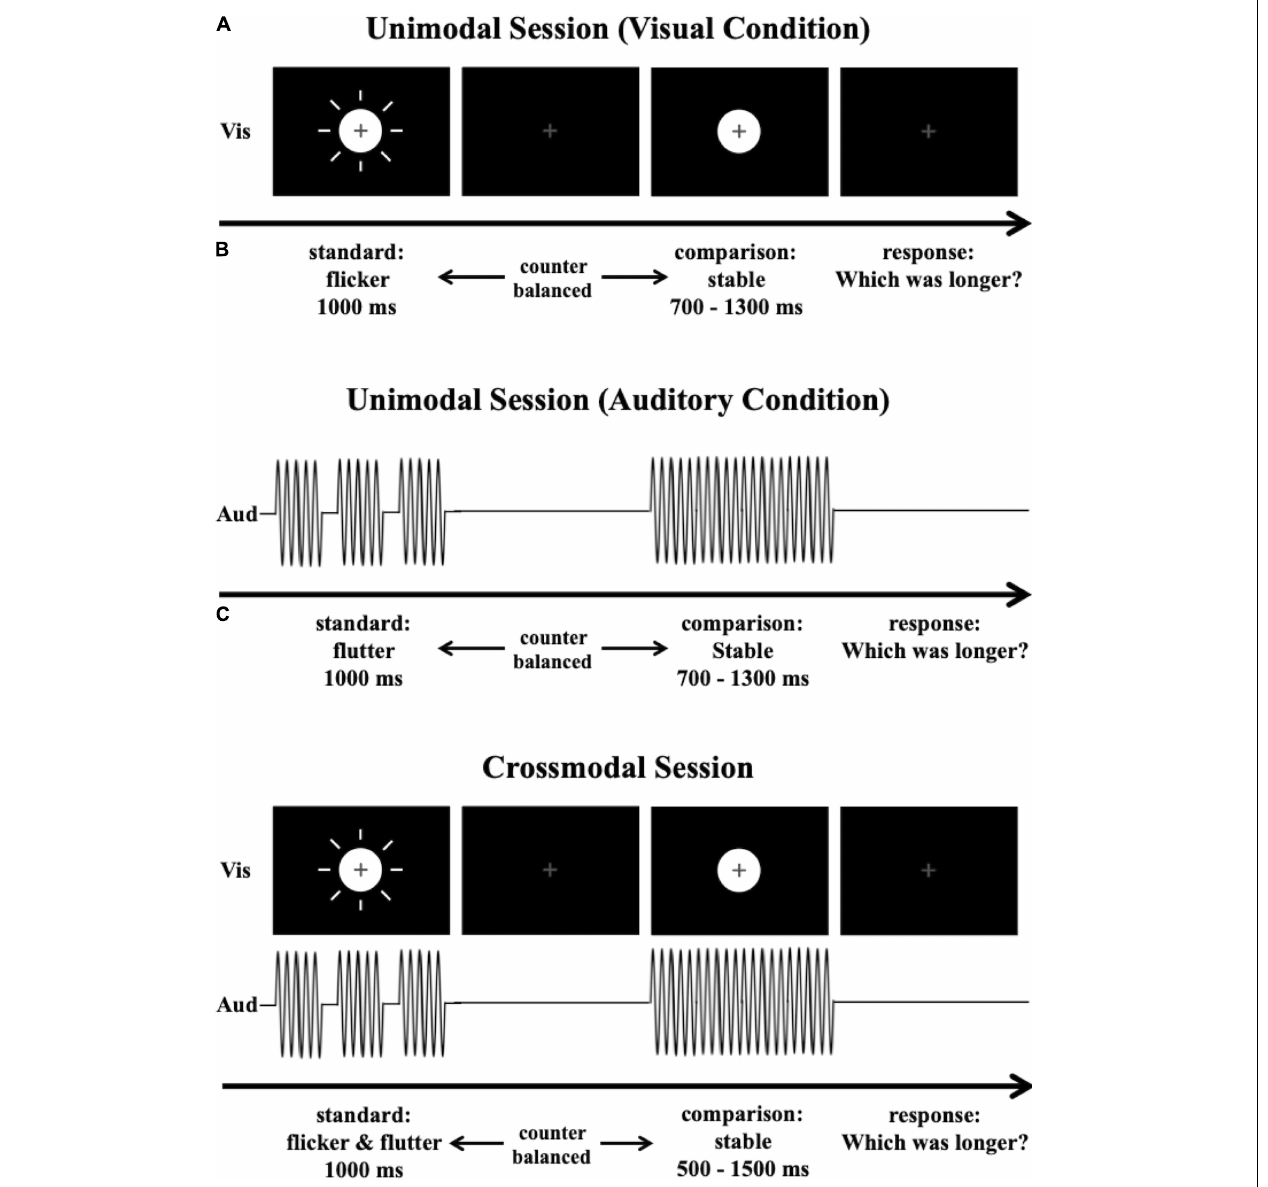
FIGURE 1 | Experimental procedure. The participants were asked to compare the duration of a standard stimulus to that of a comparison stimulus. (A) The procedure for a unimodal session in the visual condition. (B) The procedure for a unimodal session in the auditory condition. (C) The procedure for a cross-modal